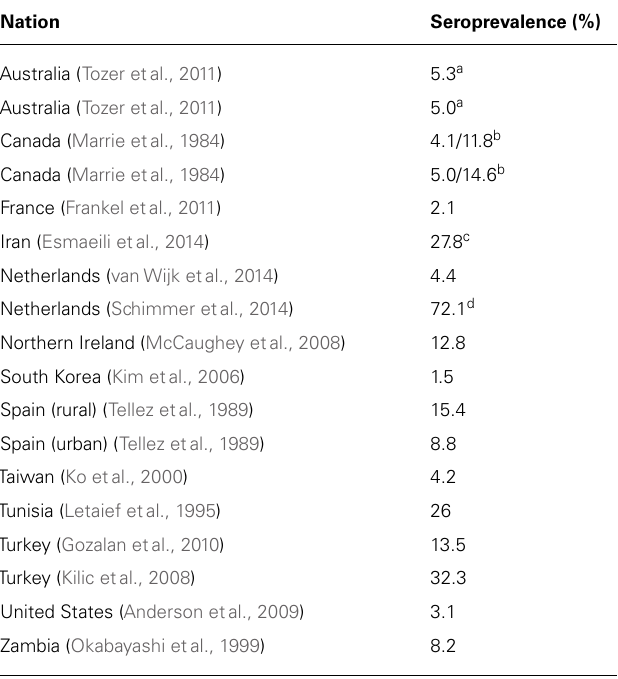
Table 1 | Highlights of seroprevalence of Q fever by